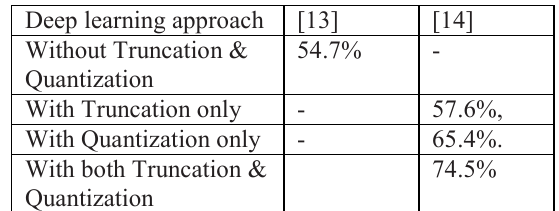
Table 1. Steganalysis results for Deep learning-based approaches